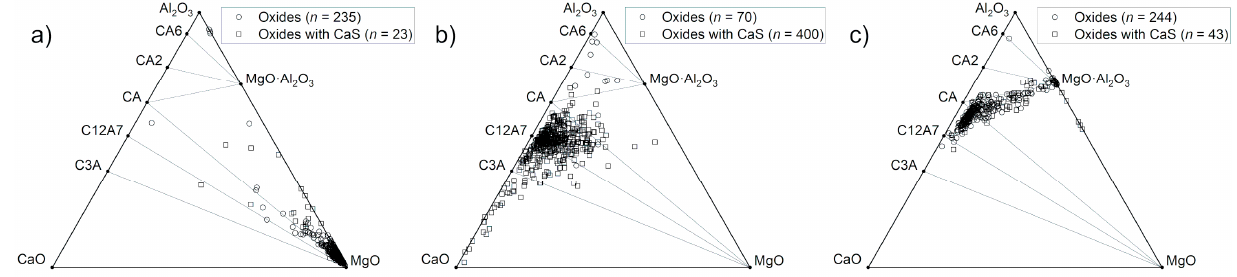
Figure 5. Oxide compositions of NMIs observed in ( a ) Sample #1, ( b ) Sample #2, and ( c ) Sample #3.